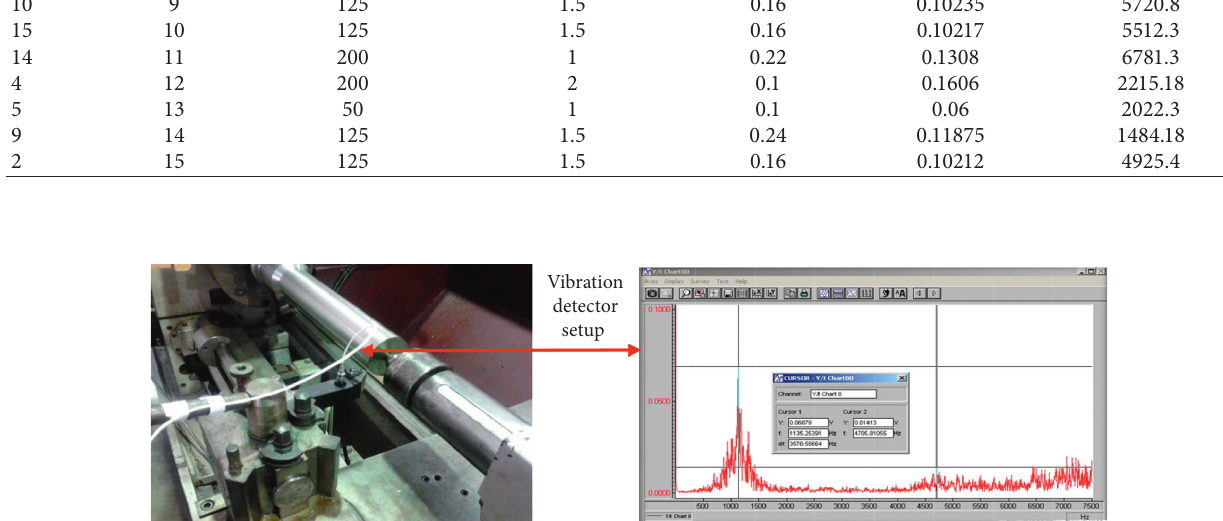
Figure 7: Vibration detector setup: (a) accelerometer setting and (b) FFT plot sample.